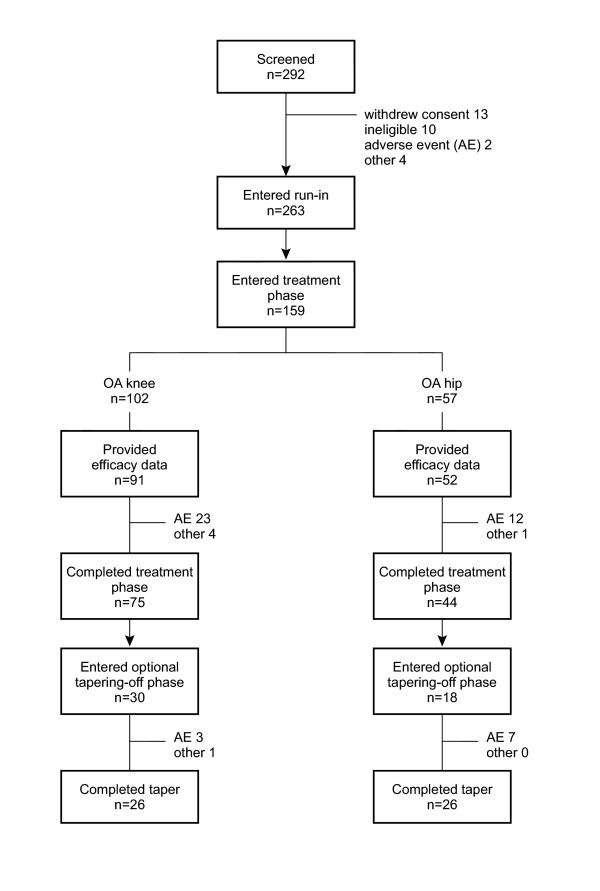
Patient disposition.